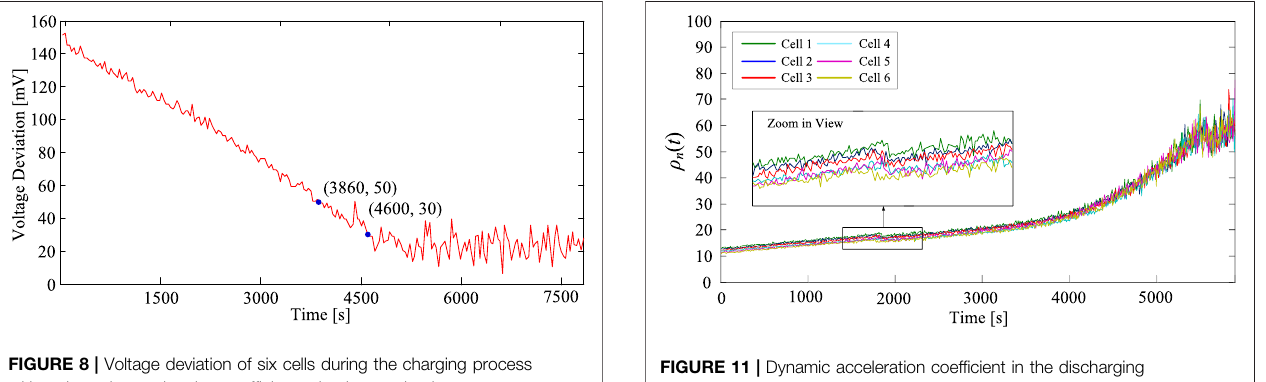
FIGURE 11 | Dynamic acceleration coef fi cient in the discharging process.